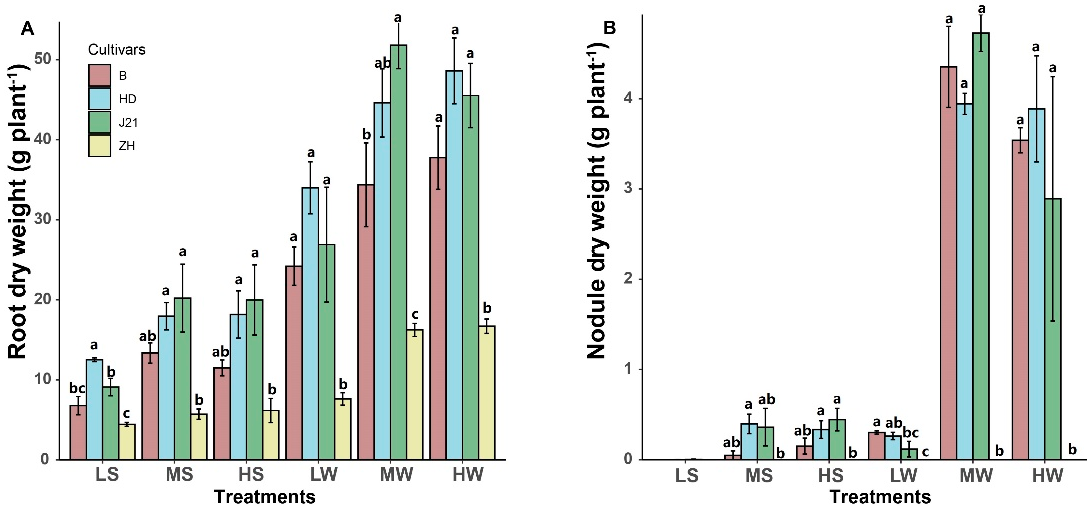
Figure 4. The root traits: root dry weight ( A ), nodule dry weight ( B ) of four genotypes under two water treatments and three P levels of four soybean genotypes [B (Bailudou), HD (Huangsedadou), J21 (Jindou 21), and ZH (Zhonghuang)] under two water treatments [S (cycle water stress), W (well- watered)] and three P levels [L, low P supply (P0), M, mid P supply (P60), H, high P supply (P120)]. The letters under each group of bars indicate different combinations of P and water treatments (as per Figure 1). Values are means plus one standard error of the mean ( n = 3).